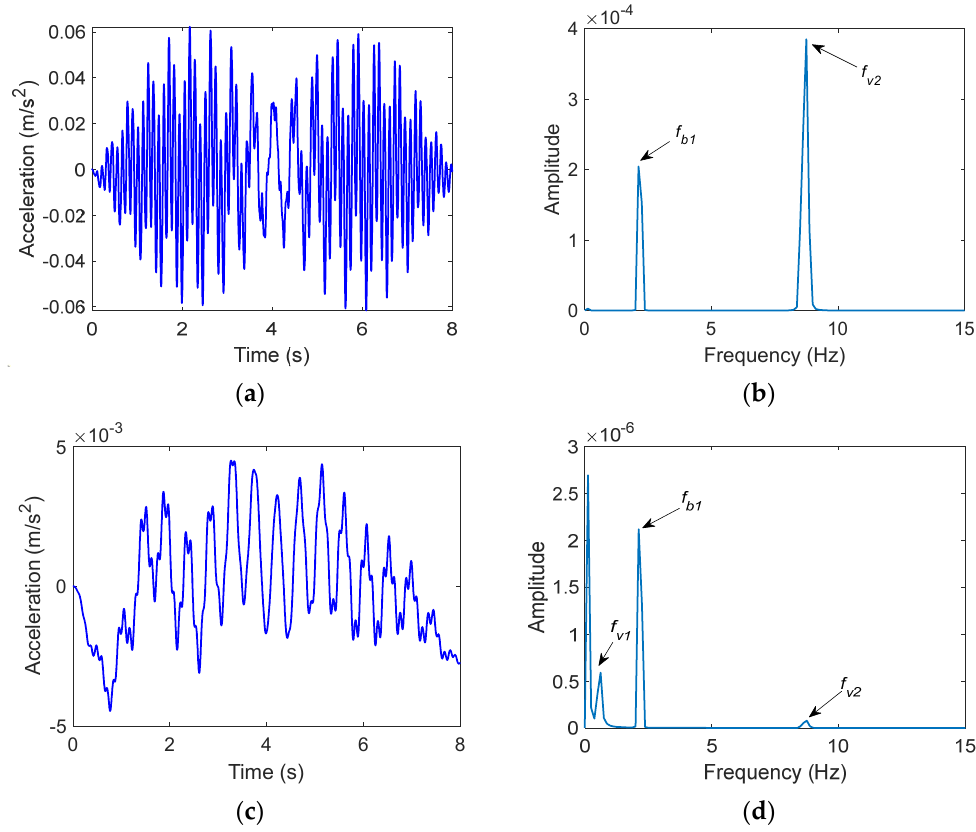
.. u a ; .. .. u s ; ( d ) spectrum for u s